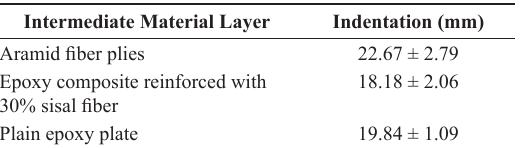
Table 1. Average depth of indentation in the clay witness backing different multilayered armors. Intermediate Material